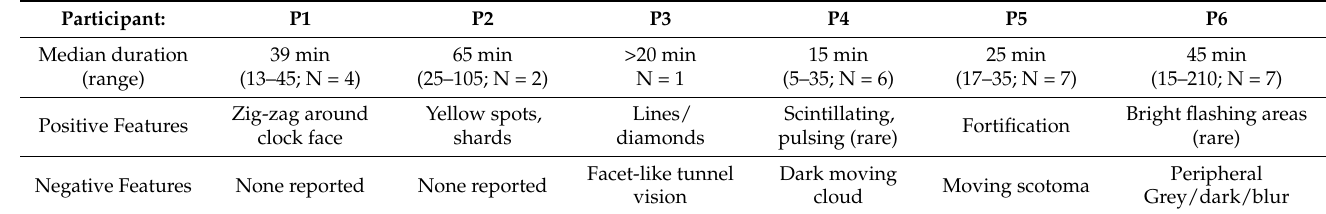
Table 3. Visual aura